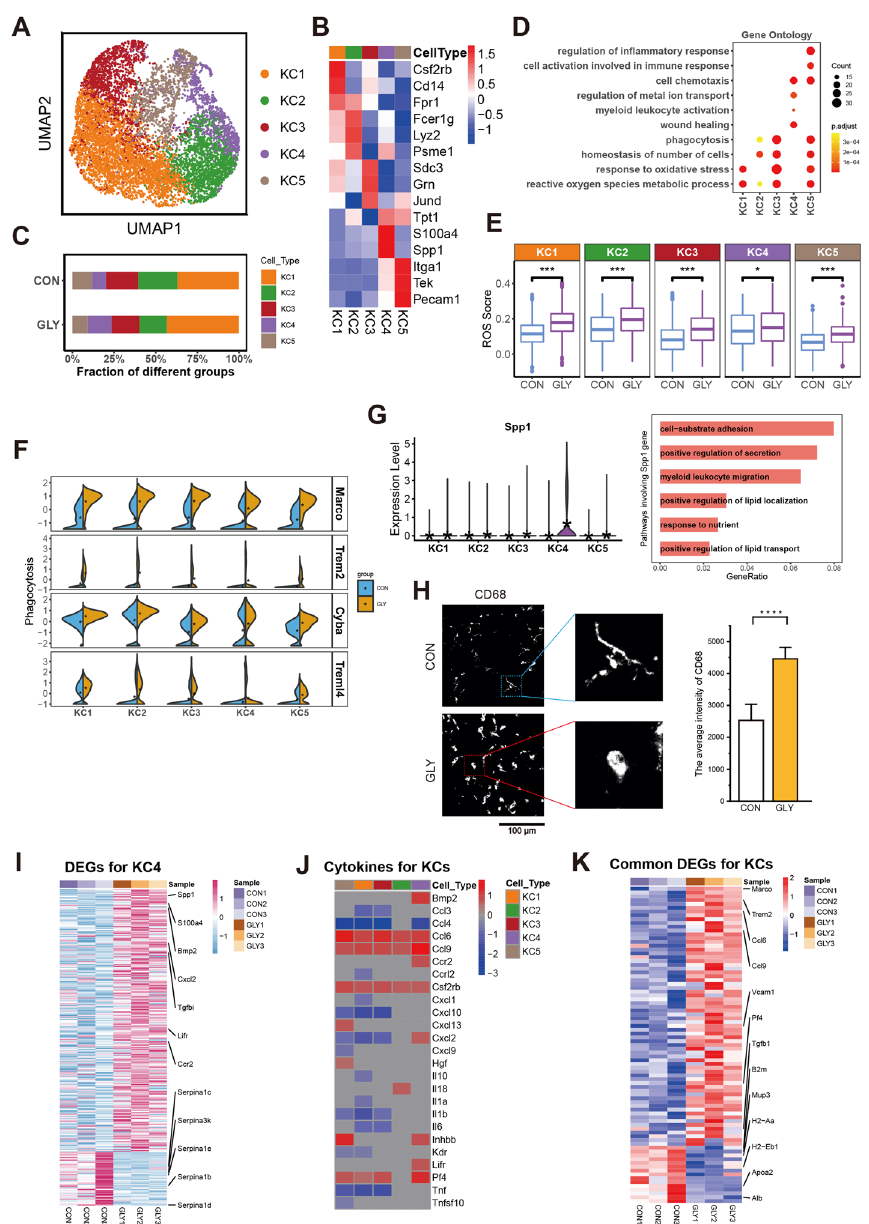
Fig. 4 Transcriptomic changes of KCs after GLY treatment. A UMAP visualization of the five subtypes for KCs. B Heatmap of the expression levels of representative marker genes in KC subtypes. C Histogram showing proportional changes of each KC subtype for two groups. D GO analysis for upregulated DEGs of different cell subtypes. E Boxplots of ROS score for each cell subtype. The middle lines indicate median values, boxes range from the 25th to 75th percentile. P value is from wilcox.test (unpaired and two-tailed); *** P < 0.001, * P < 0.05. F Split violin plots of the expression of four genes associated with phagocytosis. G Violin plots comparing the expression level of Spp1 in each subtype between control and GLY groups (left). GO analysis for upregulated DEGs of KC4 involving Spp1 gene (right). H Typical images and bar graph showing the increased expression level of CD68 after GLY treatment. Boxed regions are amplified on the right; scale bar, 100 μm; error bar, mean SD; P value is from Student’s t -test (unpaired and two-tailed); **** P 0.0001; the quantification was ± ≤ based on six random areas from each group. I Heatmap of upregulated and downregulated genes for KC4 in control and GLY samples. J Differentially expressed cytokines for each KC subtype after GLY treatment. K Heatmap for common upregulated and downregulated genes of all KC